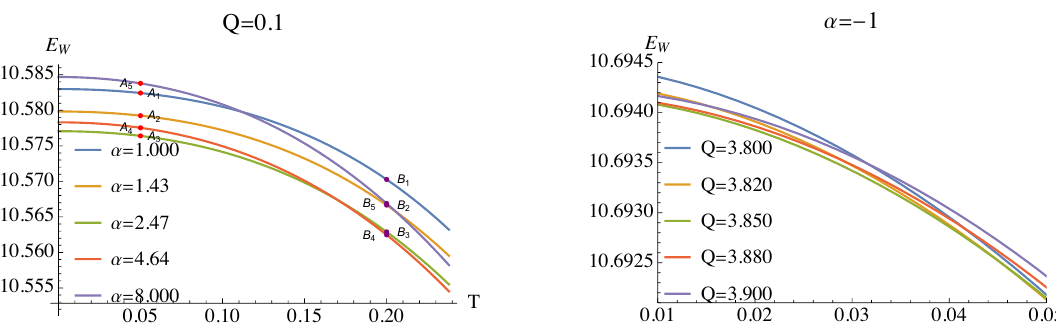
Figure 15 . The former plot is EWCS vs T in different values of α . The EWCS decrease with the increasing temperature. There are several red points and purple points that show the non- monotonicity of the EWCS vs α . The latter plot is EWCS vs T in different values of Q . The configuration ( a, b, c ) of them are both (0 . 6 , 0 . 1 , 0 . 3) .